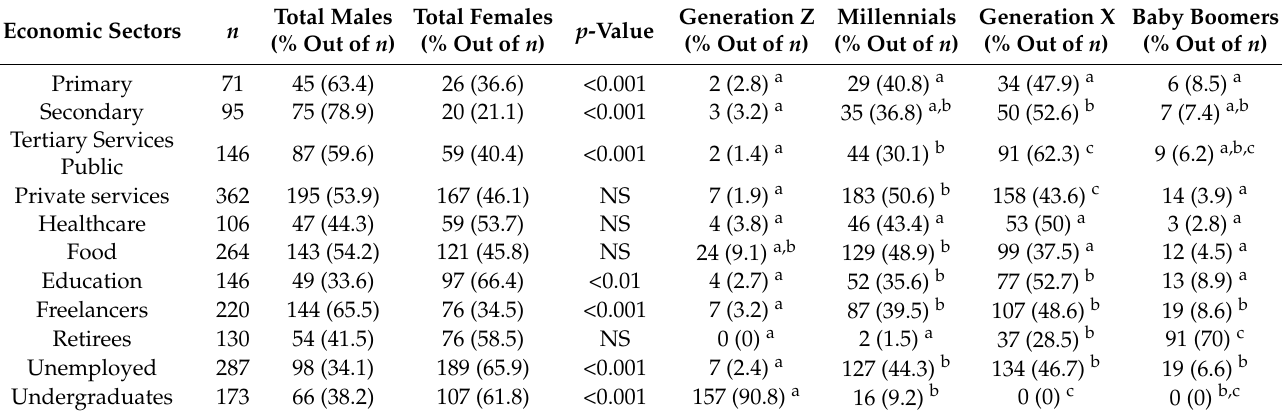
Table 1. Genders and generations amongst economic sectors in Volos, n = 2.000.